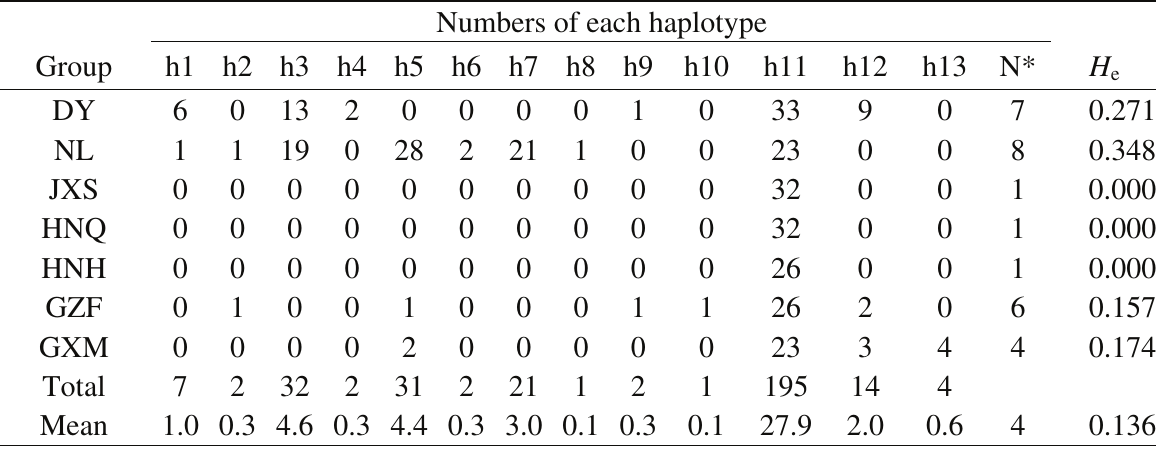
Table S1 Frequency and diversities of cpSSR haplotypes within Nothotsuga longibracteata